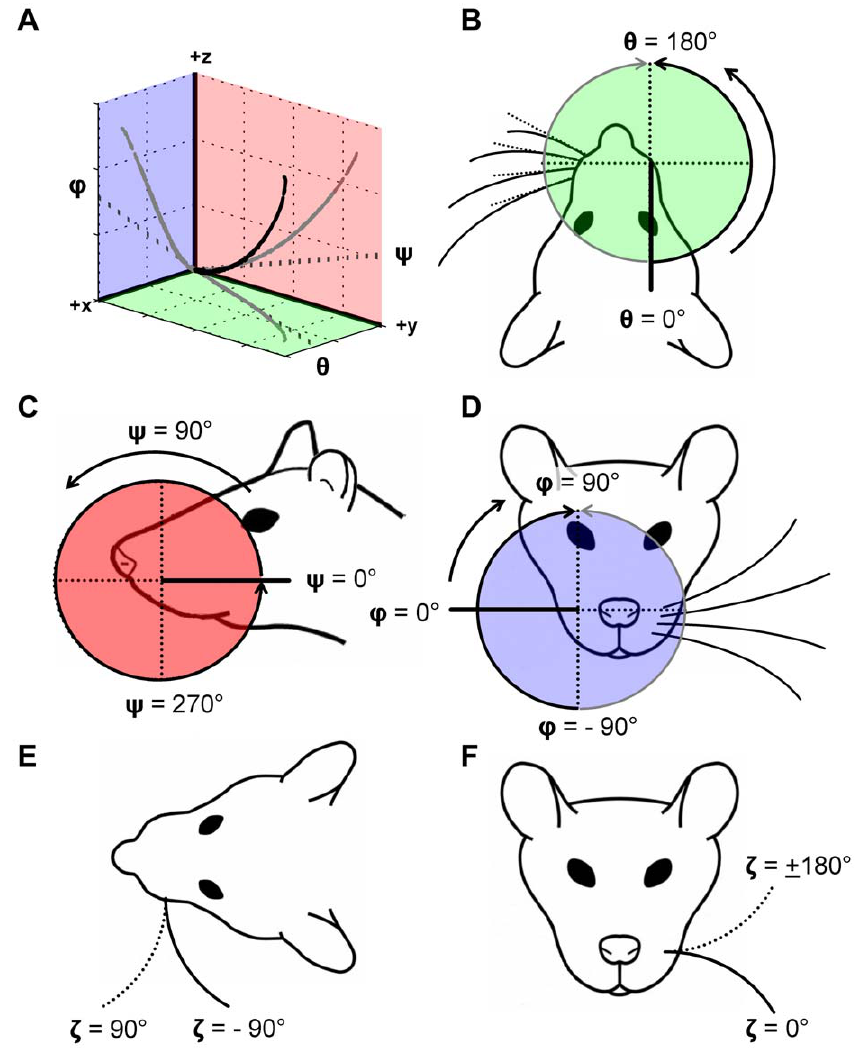
Figure 7. Whisker angle convention on the rat head. ( A ) Schematic of projection angles that describe whisker orientation in 3D. Whisker is indicated by the thick black line. Whisker projections into the three planes of the head coordinate frame are shown in gray, along with the corresponding projection angle. ( B ) Definition and range of the angle h . h increases from 0 u to 180 u on both right and left sides as the whisker protracts (identical definition for h as [13,14]). ( C ) Definition and range of the angle y . ( D ) Definition and range of the angle Q . ( E, F ) Definition and range of the angle f (identical definition for f as [10]). Whiskers on the right side of the face follow the same convention as the left for f ; therefore, a f of + 90 u has the whisker tip pointing forward for both the left and right side of the